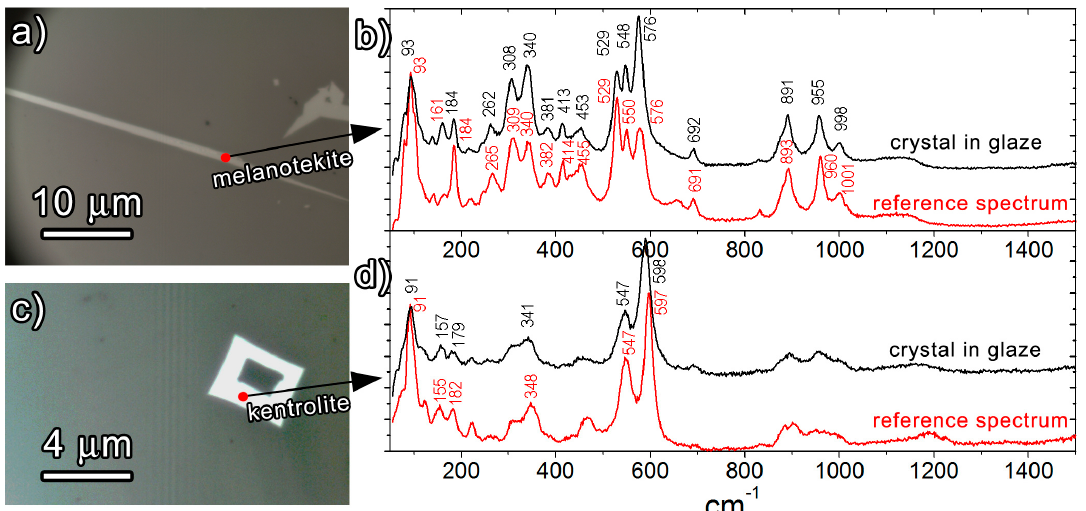
Figure 8. The Raman spectra of the crystals from the melanotekite–kentrolite series acquired using polished thin sections (data not published): Minerals from the “Systematic Collection of Minerals” of the University of Barcelona (UB, Spain) were used as reference patterns for the Raman study. ( a ) A photomicrograph of a melanotekite-type (Pb 2 Fe 1.6 Mn 0.4 Si 2 O 9 ) crystallite in a ceramic glaze acquired from a Raman camera (RL). ( b ) The Raman spectra acquired on the crystallite from Figure 8a compared with a reference spectrum of melanotekite. ( c ) A photomicrograph of a kentrolite-type (Pb 2 Fe 0.6 Mn 1.4 Si 2 O 9 ) crystallite in a ceramic glaze acquired from a Raman camera (RL). ( d ) The Raman spectra acquired on a crystallite from Figure 8c compared with a reference spectrum of kentrolite.